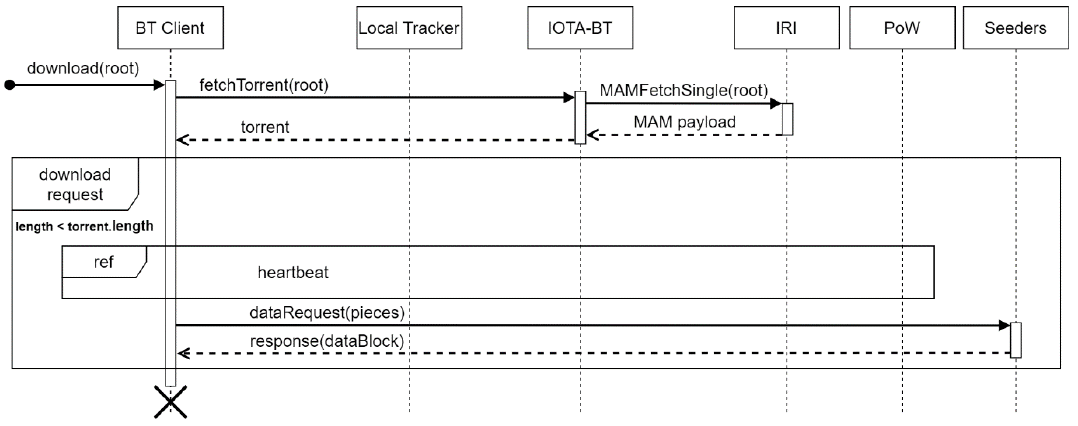
Figure 7. Download process in IOTA-BT.